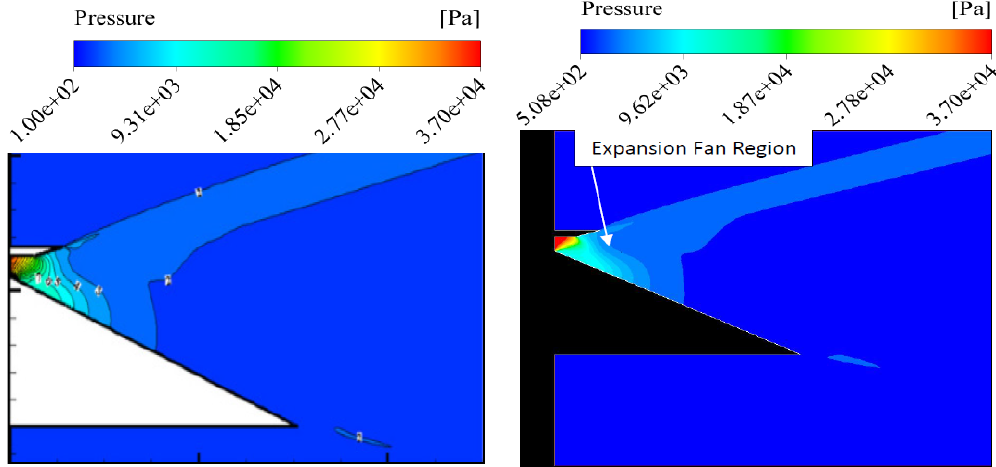
Figure 6. Comparison of static pressure contours between Huang et al. [10] ( left ) and the present analysis ( right ).